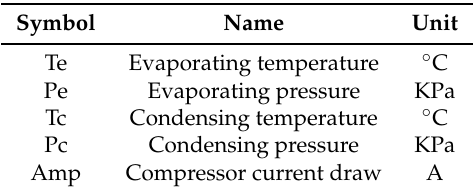
Table 2. Main variables of refrigeration